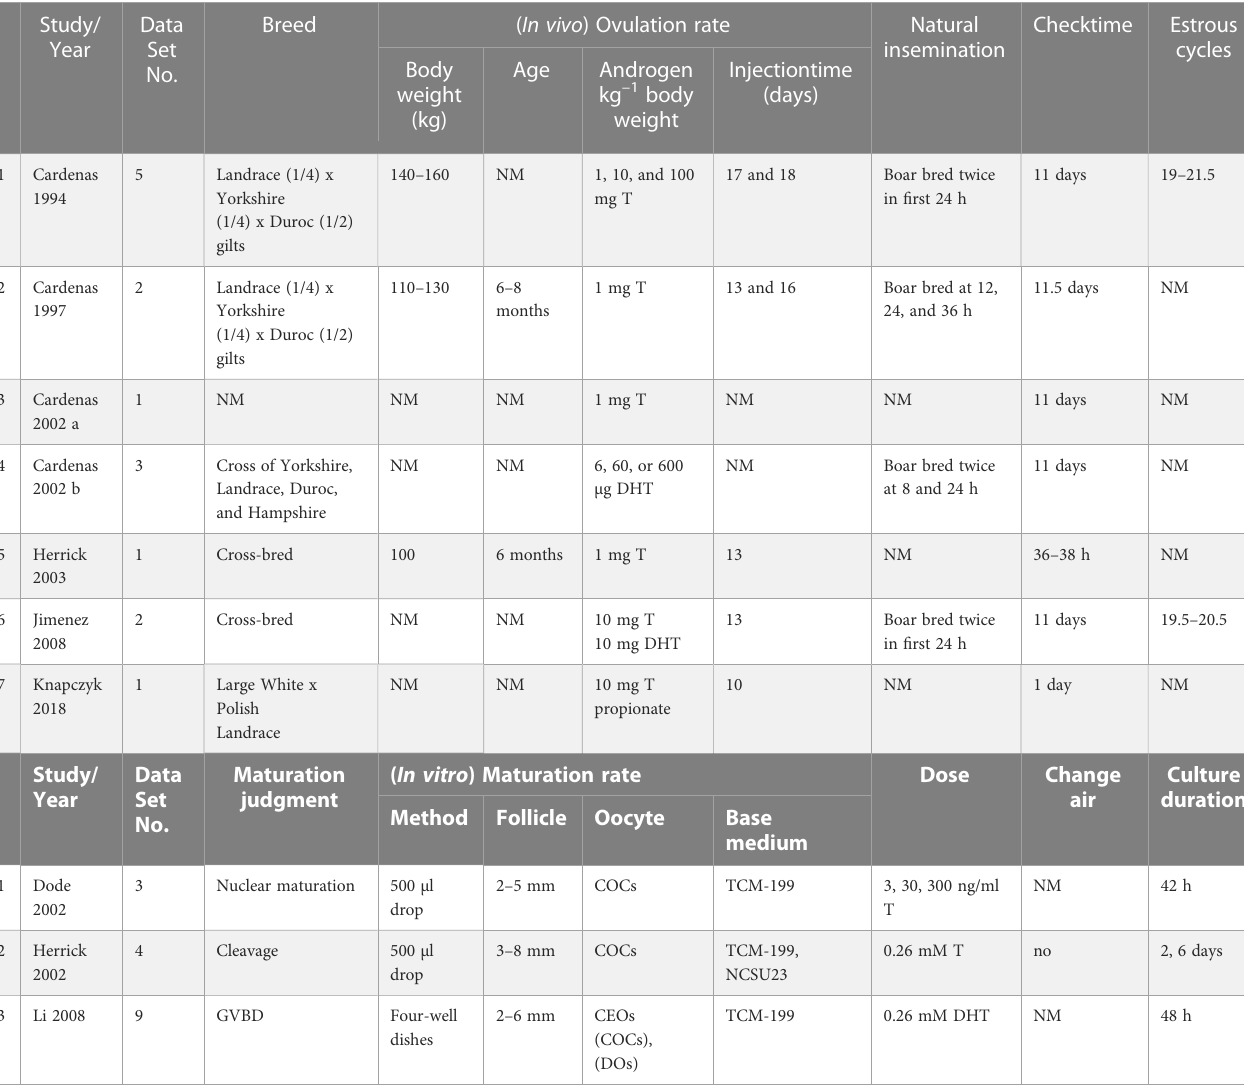
TABLE 2 Characteristics of studies